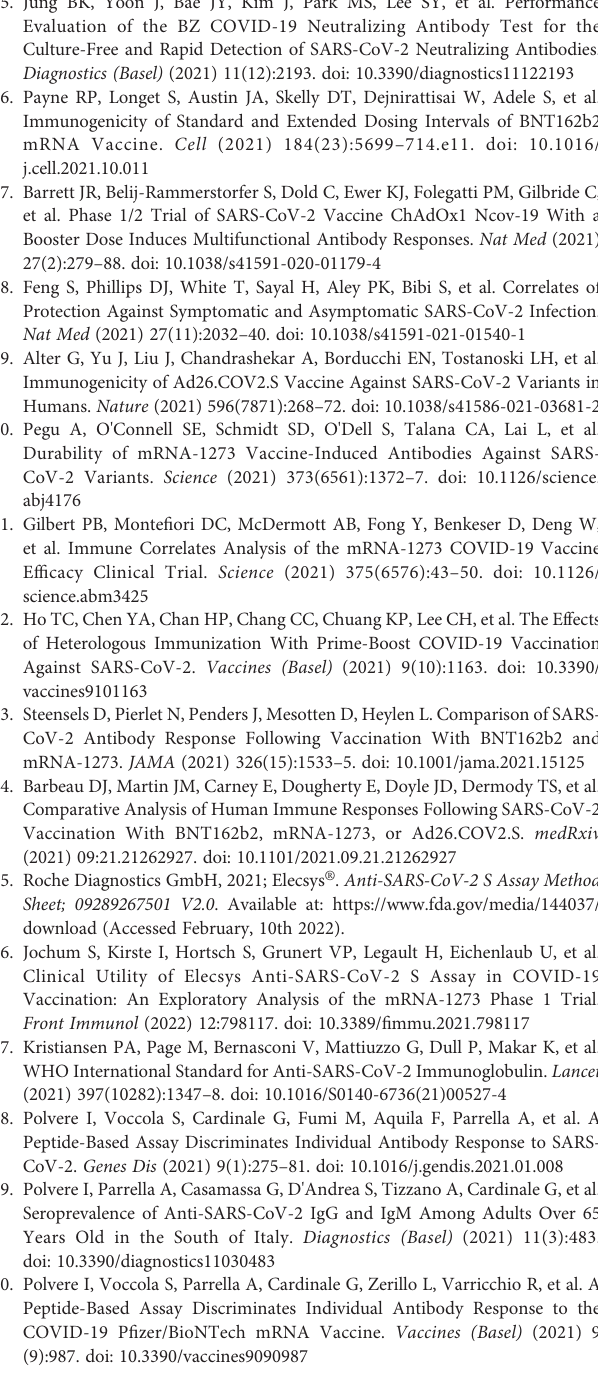
Supplementary Figure 6 | Immunoreactivity of IgG to four peptides (from top to bottom: Pep2-Spike, Pep5-Spike, Pep6-Spike, Pep10-Spike) derived from SARS- CoV-2 Spike in sera from individuals that received different vaccines: BNT162b2, ChAdOx1 nCov19; Ad26.COV2.S; mRNA-1273; COVID19 + vaccine; mixed vaccines. The antibody response is reported as a log 2 fold-change (mean ± SD) compared to negative control sera. A positive response was arbitrarily scored for a log 2 fold-change > 1 (see red line). Experiments were performed in